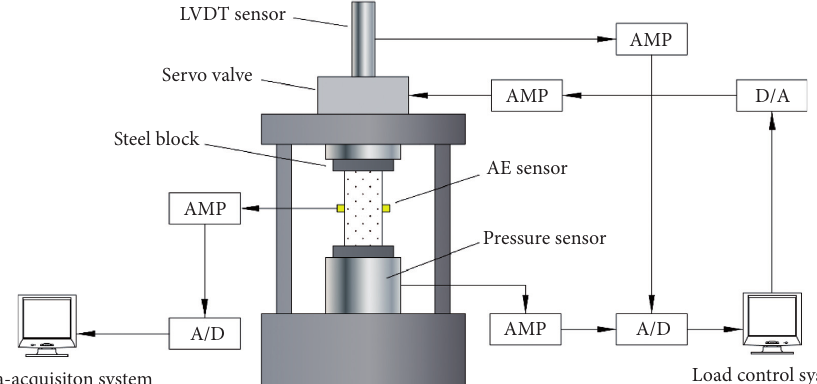
Figure 2: GAW-2000 testing system equipped with AE monitoring.